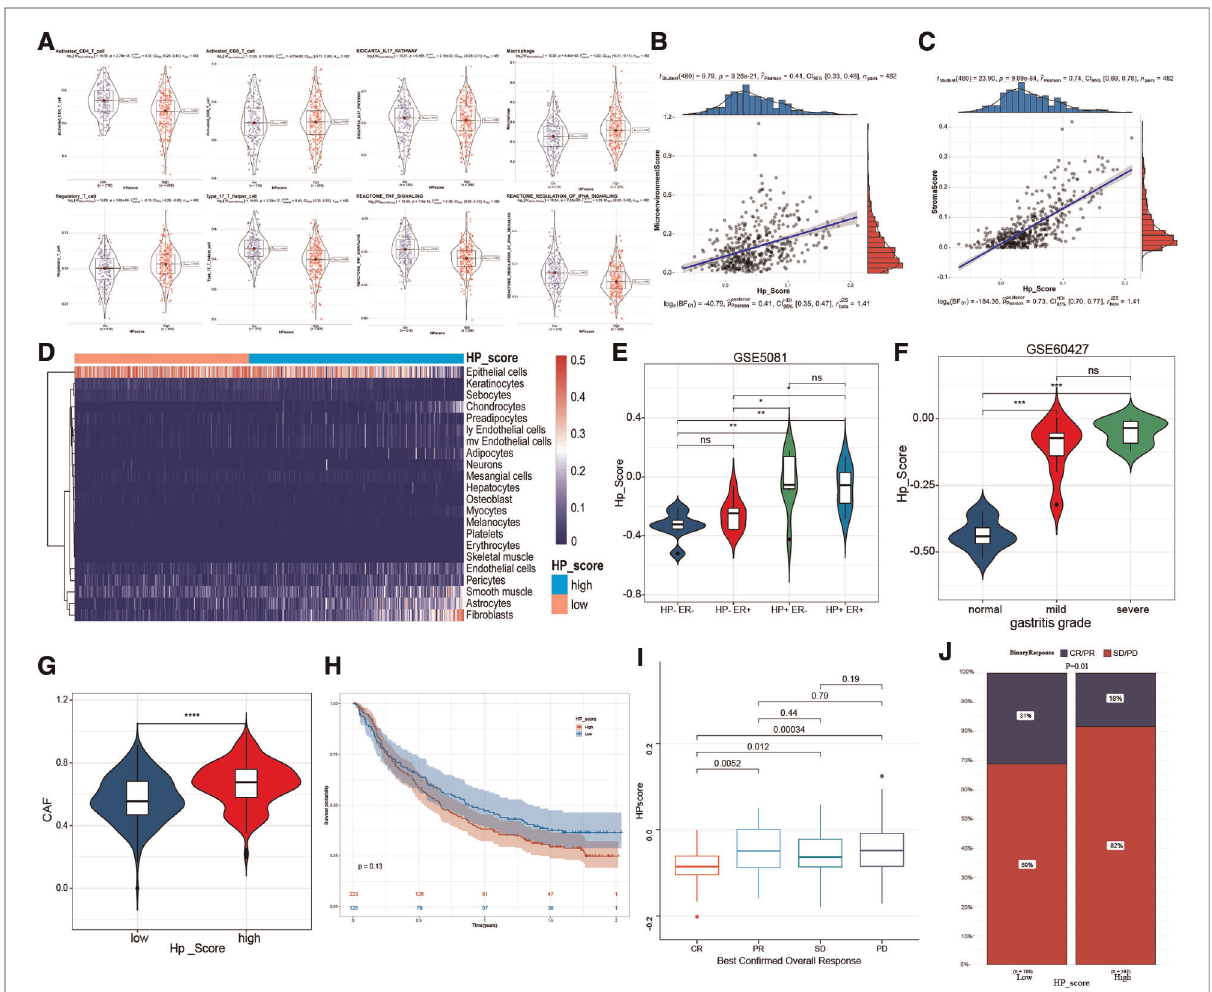
FIGURE 6 The immune-related characteristics of HPscore. ( A ) Signi fi cant differences of immune cell in fi ltration between high-HPscore and low-HPscore groups. ( B,C ) A scatter plot of the positive relationship between HPscore and Stromastore and Microenvironmentscore. ( D ) The heatmap shows the different distribution of stromal cells between both groups. ( E,F ) The signi fi cant differences of HPscore in patients with different levels of HP infection. ( G ) Relative distribution of CAF cells in HPscore high vs. low subgroups. ( H ) Kaplan-Meier curves for high and low HPscore patient groups receiving anti-PDL1 treatments. ( I,J ) The fraction of patients with clinical response to anti-PDL1 immunotherapy in low or high HPscore